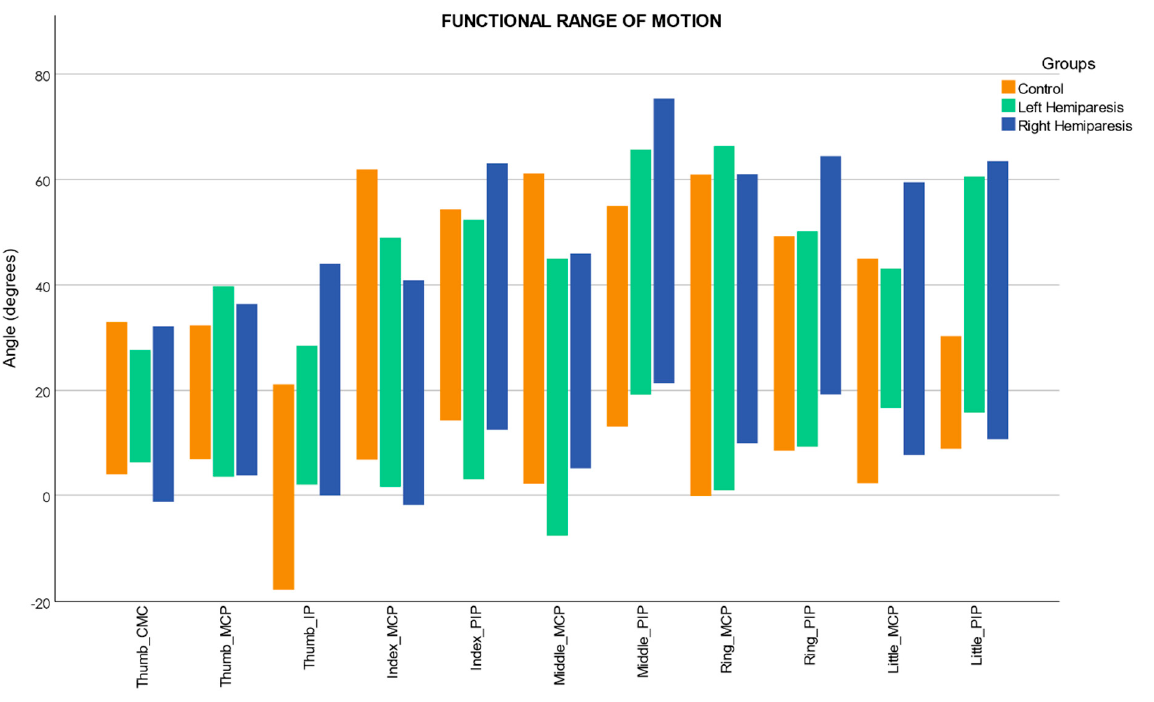
Figure 2. Functional range of motion in each finger joint; CMC = carpometacarpal; MCP = metacar- pophalangeal; IP = interphalangeal; PIP = proximal interphalangeal; negative values represent hyperextension; maximum = flexion; minimum = extension. Table 3. Flexion angles of the functional range of motion (FROM) during 14 tests.